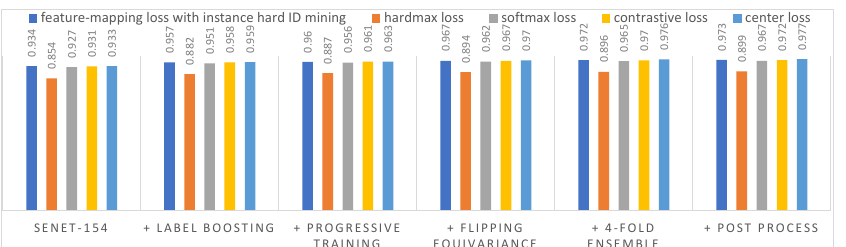
Figure 4. Experimental results with different loss functions. We selected four different loss functions: the softmax loss, which is commonly used in multiclassification tasks, the hardmax loss, the con- trastive loss [52], and the center loss [53]. The classification loss with global and local feature-matching loss achieved the best